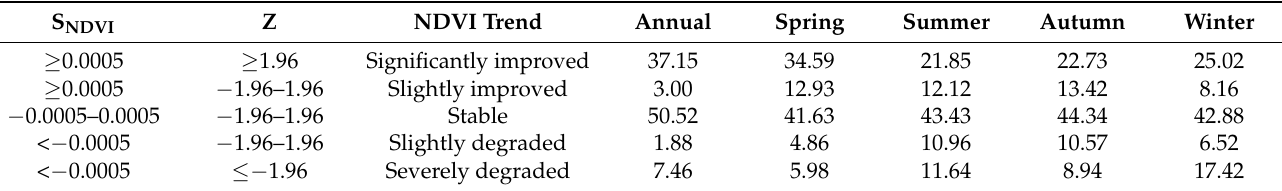
Table 3. NDVI trends in